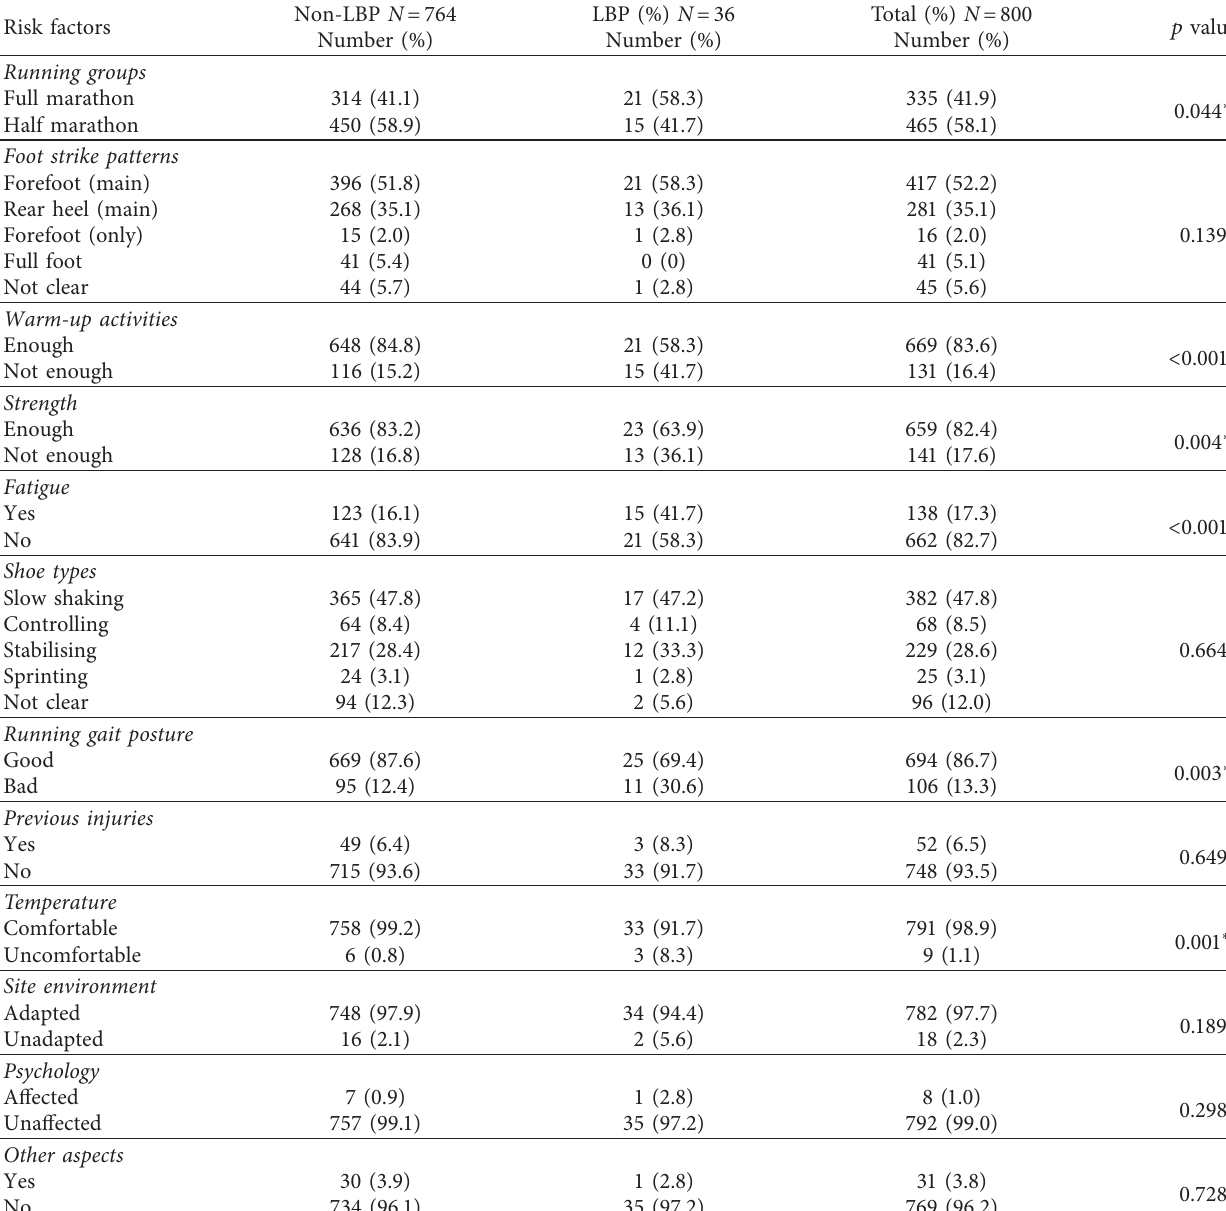
Table 2: Summary of risk factors for LBP in marathon